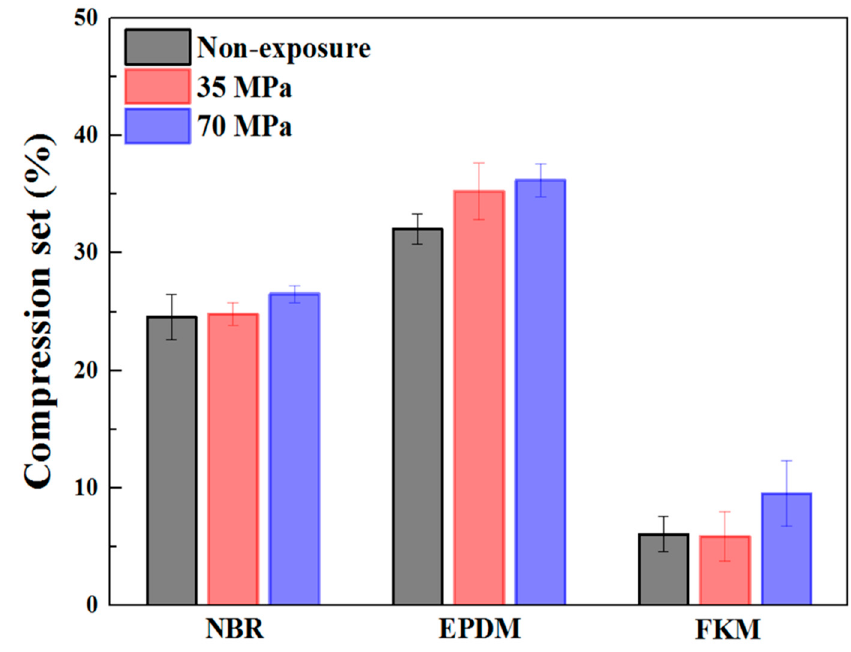
Figure 6. Result of compression set for NBR, EPDM, and FKM.